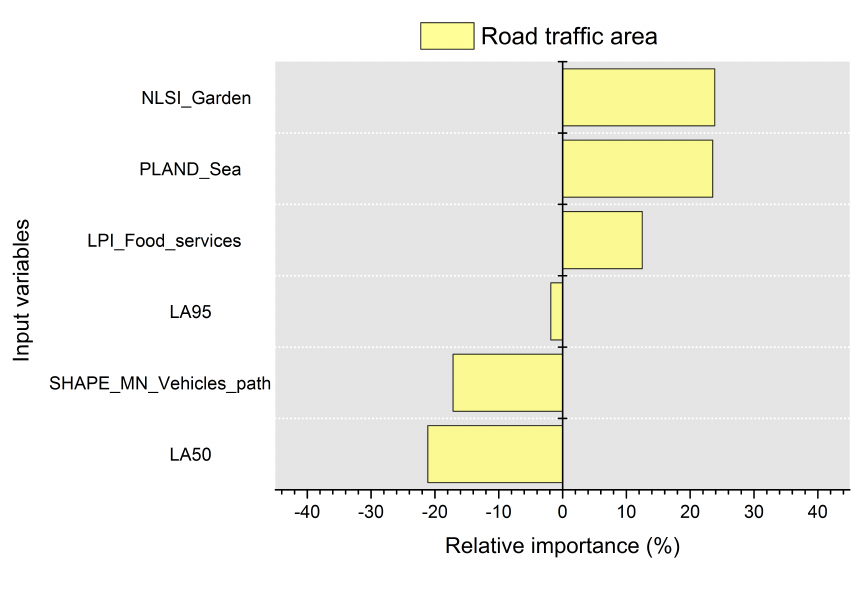
Figure 9. Percentage of relative importance of the predictors on the results calculated with the Olden et al. method for the road traffic areas. Values higher than zero mean a positive relative effect, and lower than zero, a negative relative effect. The input variables are from top to bottom spatial metric “normalized landscape shape” calculated for the land use “garden” (NLSI_Garden), spatial metric “percentage of land use” calculated for the land use “sea” (PLAND_Sea), spatial metric “large patch index” calculated for the land use “food service” (LPI_Food), A-weighted sound pressure level exceeded 95% of time (LA95), spatial metric shape calculated for the land use “vehicles path” (SHAPE_MN_Vehicles_Path) and A-weighted sound pressure level exceeded 50% of time